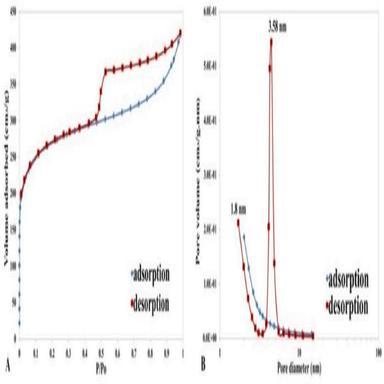
A) N2 adsorption/desorption isotherm curves. B) BJH pore size distribution (dV/dD).